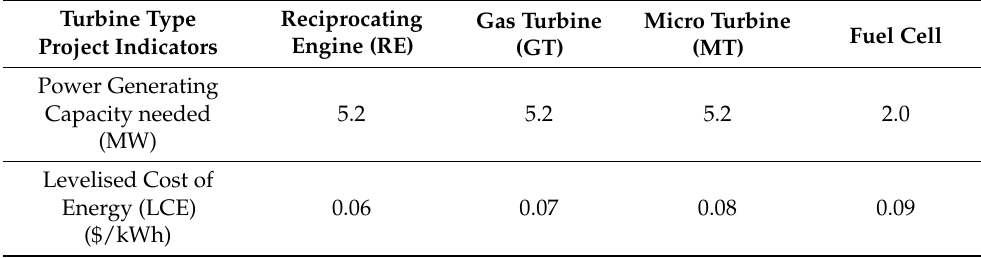
Table 3. Project specifications of energy recovery potential from process industry effluents.